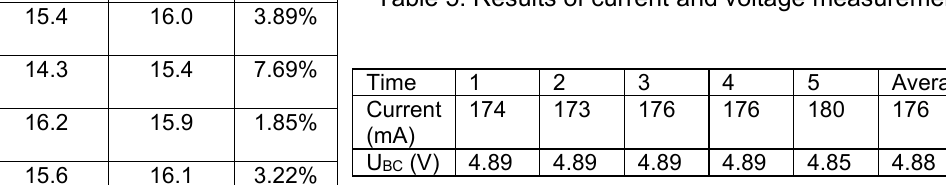
Table 5. Results of current and voltage